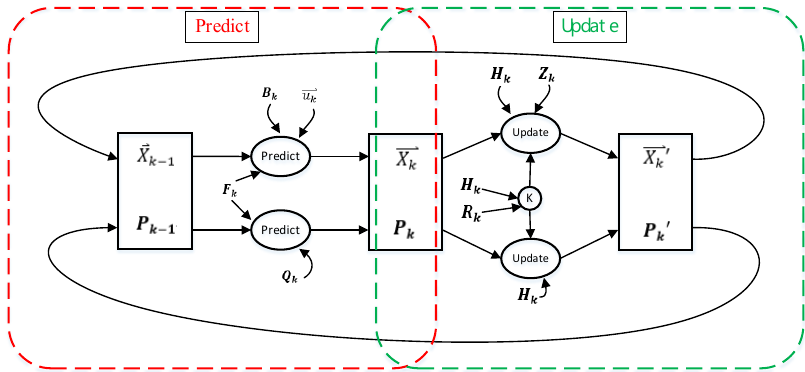
Figure 4. Kalman filter algorithm calculation flow chart.